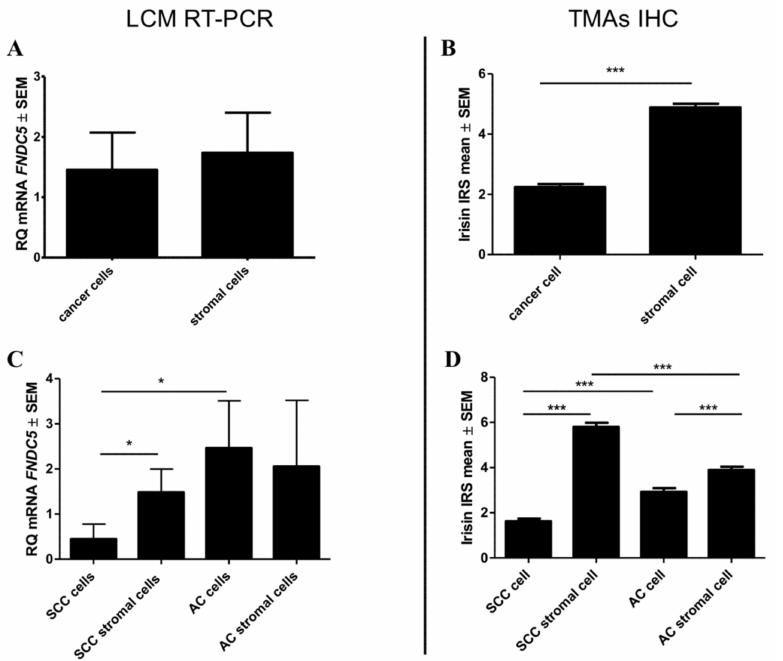
Figure 3. Comparison of mRNA FNDC5 expression levels collected by using Laser Capture Microdissection and detected by real-time PCR ( A , C ) with irisin expression levels detected by IHC reactions performed on Tissue Microarrays ( B , D ) in cancer cells and stromal cells of NSCLC ( A , B ) and according to subtypes: SCC and AC ( C , D ) *** p ≤ 0.001, * p ≤